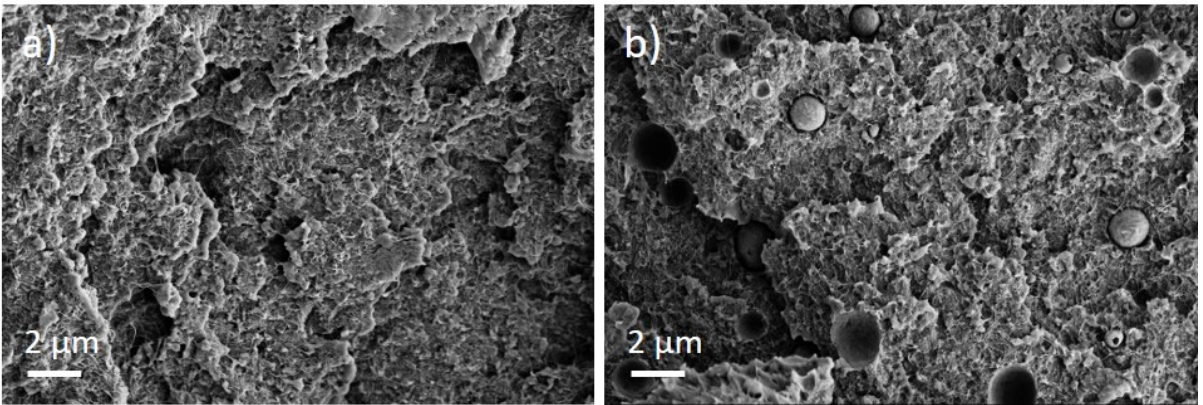
Figure 7. Scanning electron microscopy images of cryo-fractured surface of ( a ) PEEK/1 wt% Tuball™ without PEG and ( b ) with 2 wt% PEG.